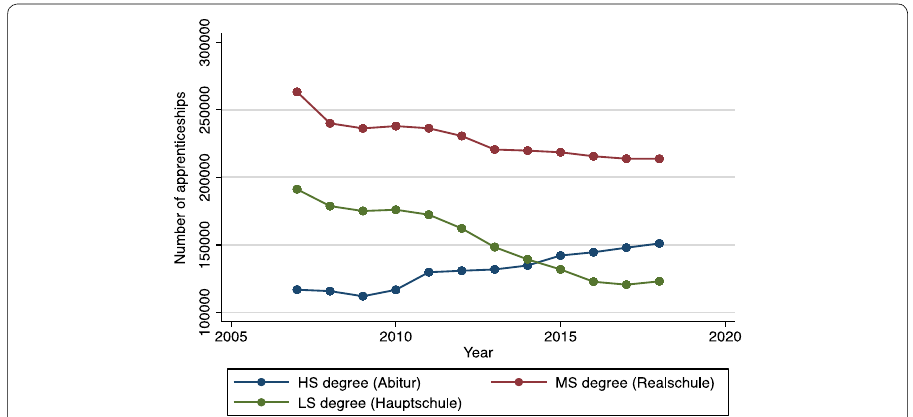
Fig. 5 Number of apprenticeships by prior educational attainment (2007–2018). Source: Vocational Training Statistics of the statistical offices of the federal and state